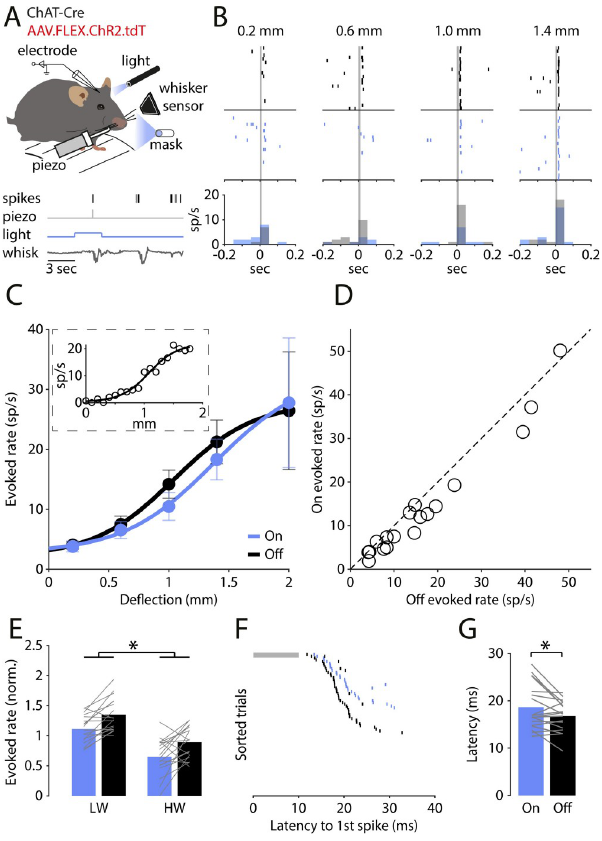
Fig 5. VChIs inhibit the sensory response elicited by whisker deflection. (A) Illustration of the experimental system: cell-attached recordings are performed from putative excitatory cells in an awake, head-fixed mouse. In each trial, a piezoelectric deflection in a random amplitude (0.2, 0.6, 1.0, or 1.4 mm) is delivered to the whiskers, and optogenetic stimulation is either delivered (“On” trial) or not (“Off” trial). (B) Example of the response of a single cell to the 4 whisker deflection amplitudes in the Off and in the On trials. (C) Population average of the response of all cells to the whisker deflections in the Off and On trials. Inset: example of the sigmoidal response of a cell in which the whiskers were deflected in 19 different amplitudes. (D) The average evoked rate for each cell in the intermediate range of the sigmoidal curve. (E) Evoked rate in the Off and On trials in LW and HW trials. (F) The response of a cell to whisker deflection, sorted by the lag to the first deflection-evoked spike (grey horizontal bar: piezoelectric stimulation). (G) The latency to the first evoked spike in the On and in the Off trials across the population. ChAT, choline acetyltransferase; HW, high whisking; LW, low whisking; sp/s, spikes per second; VChI, VIP/ChAT interneuron; VIP, vasoactive intestinal polypeptide.